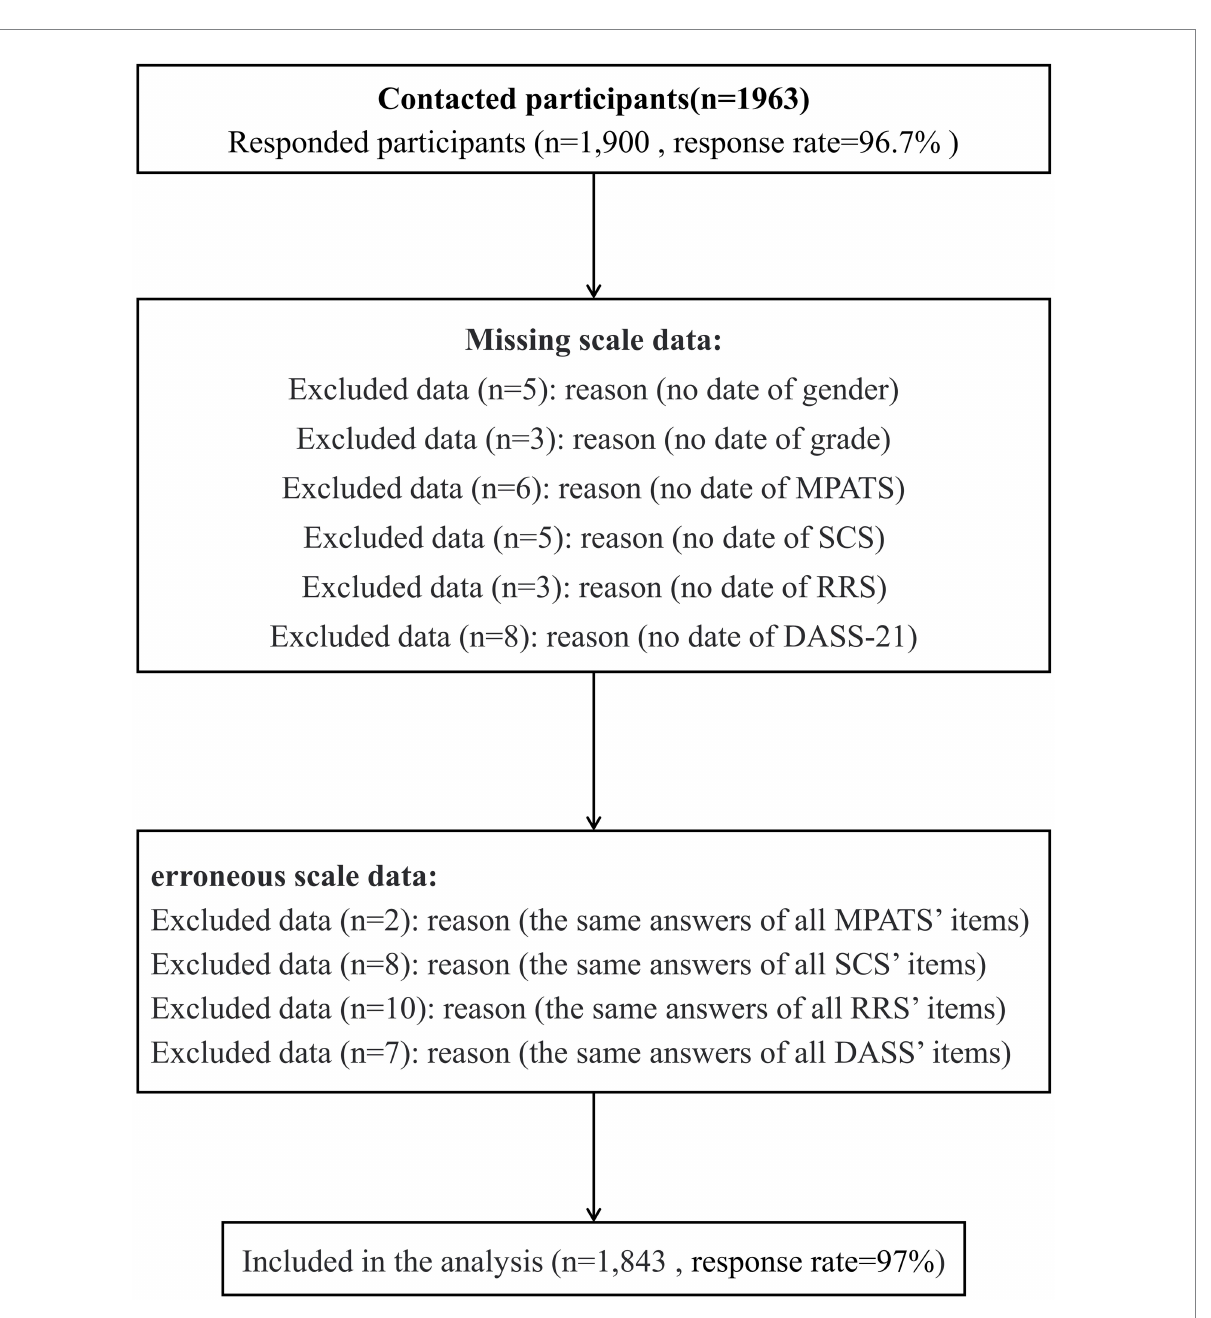
FIGURE 2 The procedure of obtaining final study